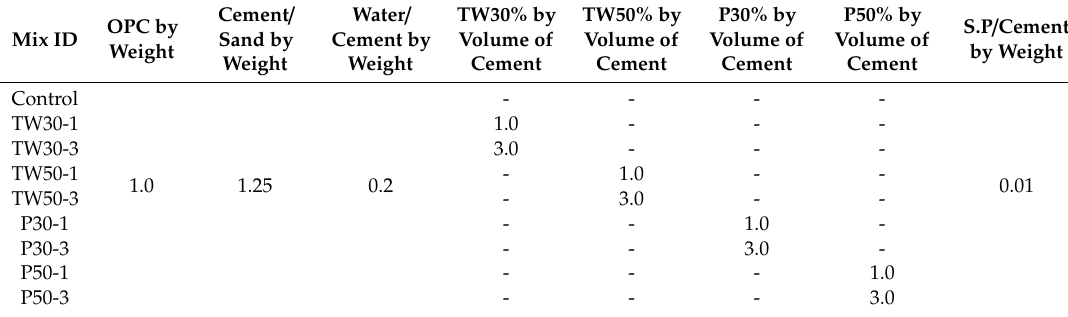
Table 2. Mix proportions of mortar